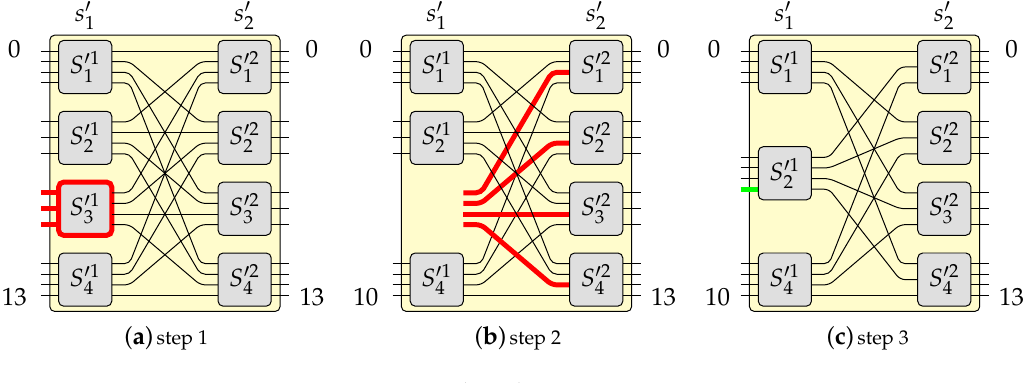
Figure 6. Algorithm 1—steps 1–3.